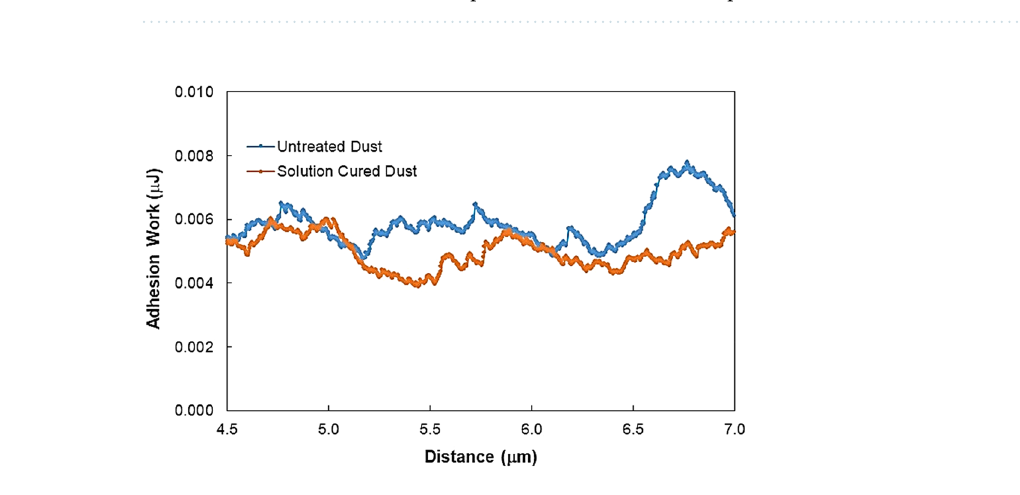
Figure 7. Work adhesion along the scanning (scratching) length on dusty glass